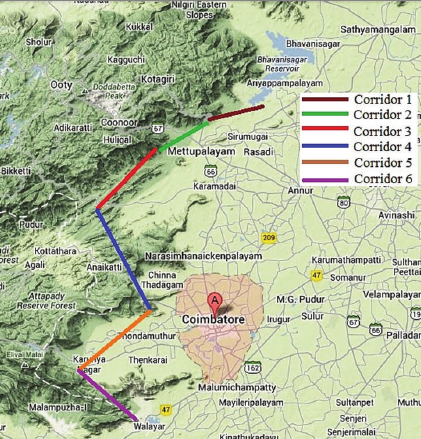
Figure 1: Map showing study area of the Coimbatore district in Tamil Nadu.